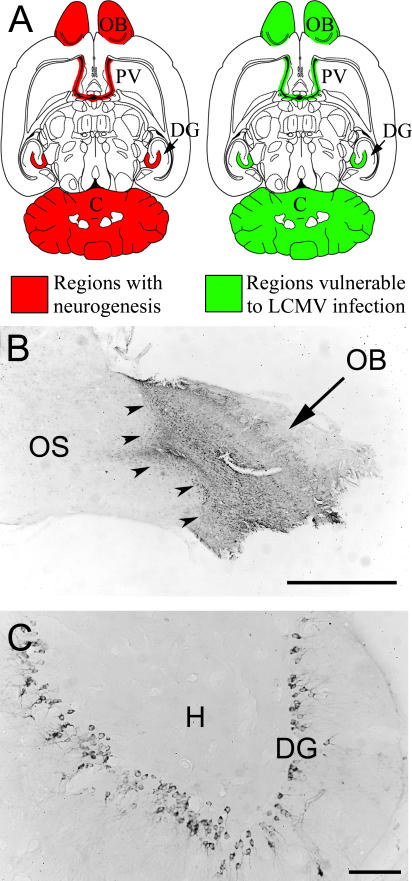
Within the Developing Brain, LCMV Induces a Specific Pattern of Infection, in which Brain Regions Containing Mitotically Active Neuronal Precursors Are Selectively Infected(A) During the early postnatal period in the rat, neurogenesis continues in four brain regions. These regions include the olfactory bulb (OB), periventricular region (PV), dentate gyrus (DG), and cerebellum (C). These four regions in which neurogenesis occurs are precisely the same four regions in which neurons are vulnerable to LCMV infection.(B) Micrograph illustrating the selective infection of the olfactory bulb by LCMV. This is a 50-μm-thick section through the anterior forebrain of a 30-d-old rat inoculated with LCMV on PD4. The section has been immunohistochemically stained for LCMV antigens. Note that the olfactory bulb (OB) is selectively infected. The immediately adjacent olfactory stalk (OS) is free of infection. The arrowheads demarcate the line between the olfactory bulb (right of arrowheads) and olfactory stalk (left of arrowheads) and demonstrate the highly selectivity pattern of LCMV infection.(C) Micrograph illustrating the selective infection of the dentate gyrus. This section was obtained from the same LCMV-infected animal shown in (B) and is immunohistochemically stained for LCMV antigen. Note that the neurons of the dentate gyrus (DG) are selectively infected, while the neurons of the immediately adjacent hilus (H) are entirely spared.Magnification bars represent 1 mm in (B) and 100 um in (C).